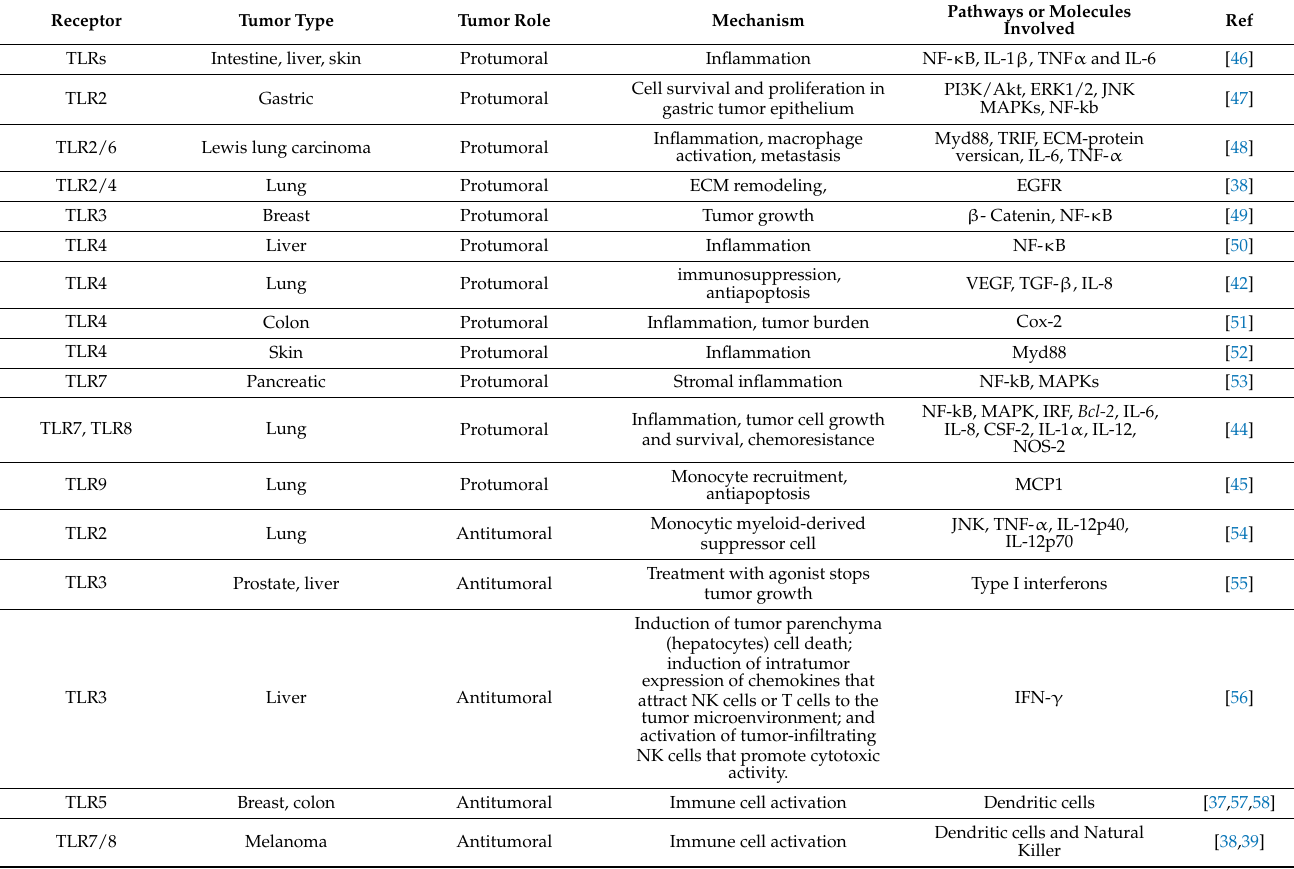
Table 1. Pro- or anti-tumoral effects mediated by